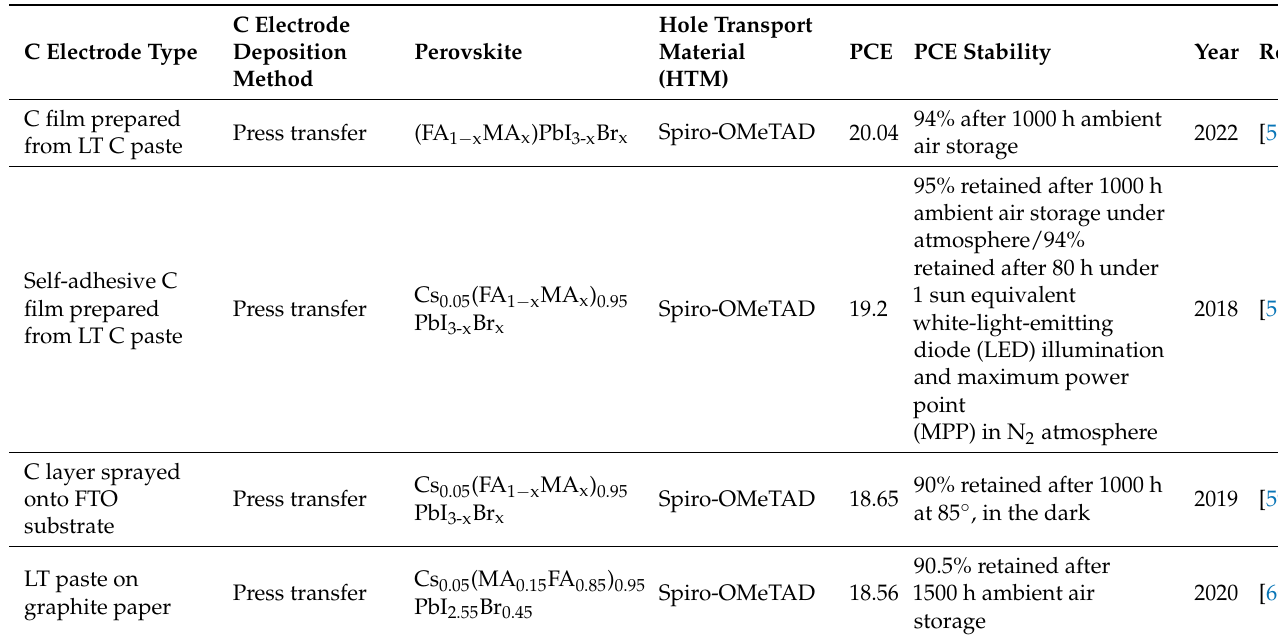
Table 2. Summary of the highest PCEs obtained so far in lab-scale PSCs employing a C